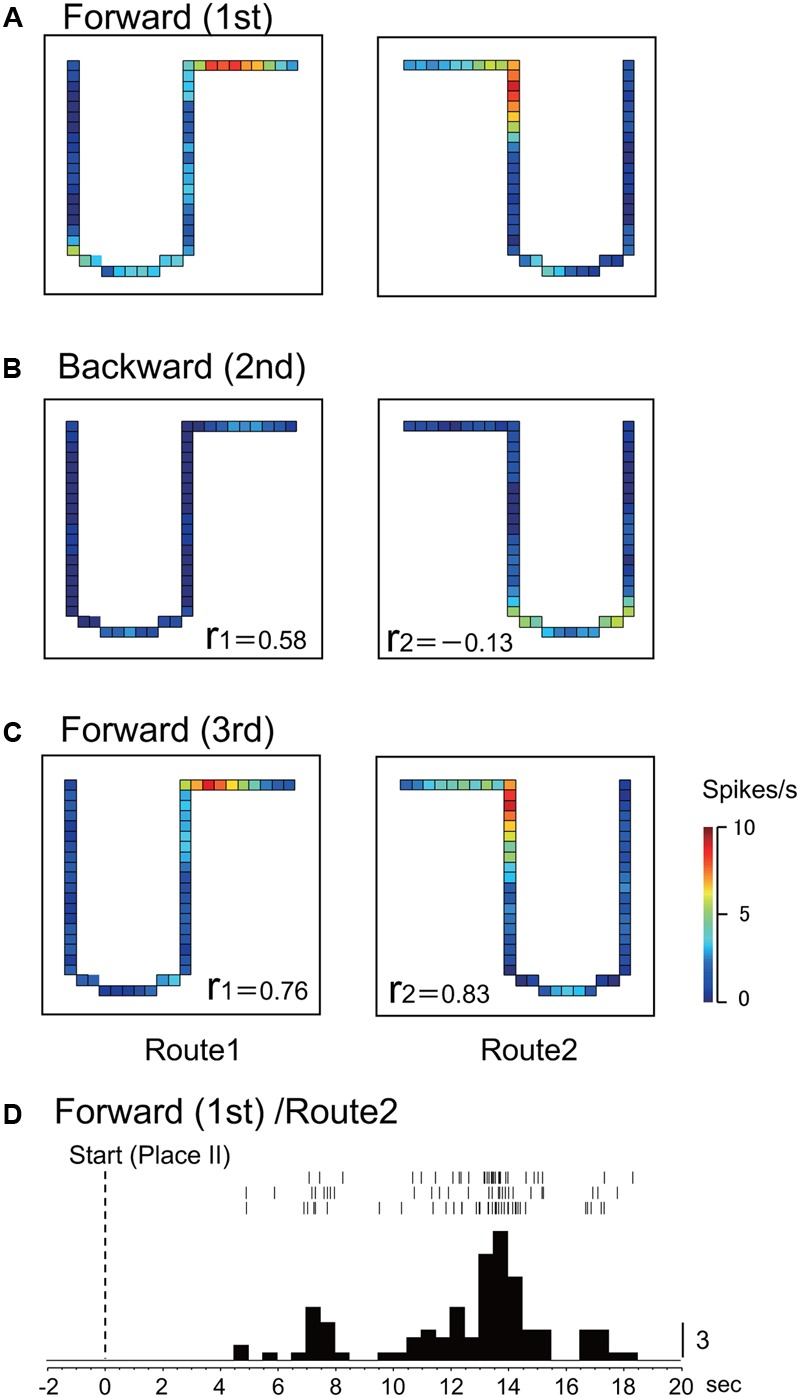
An example of a forward-related place-differential activity. (A–C) This activity displayed place fields in both Routes 1 and 2 in the 1st (A) and the 3rd (C) forward sessions, but not in the 2nd backward sessions (B). r, correlation coefficients between firing-rate distributions in the first control session and the following given session in Route 1 (r 1) and Route 2 (r 2), respectively. The color of each pixel indicates neuronal activity calibrated at the right bottom (spikes/s). (D) Peri-event time histogram of the neuronal activity during forward translocation in Route 2 in the 1st session. The neuronal activity increased around 13 s after the start from Place II. A histogram shows summed neuronal activity. Each histogram bin, 500 ms; calibration at right of each histogram, number of spikes in each bin. The histograms were aligned with start of translocation.